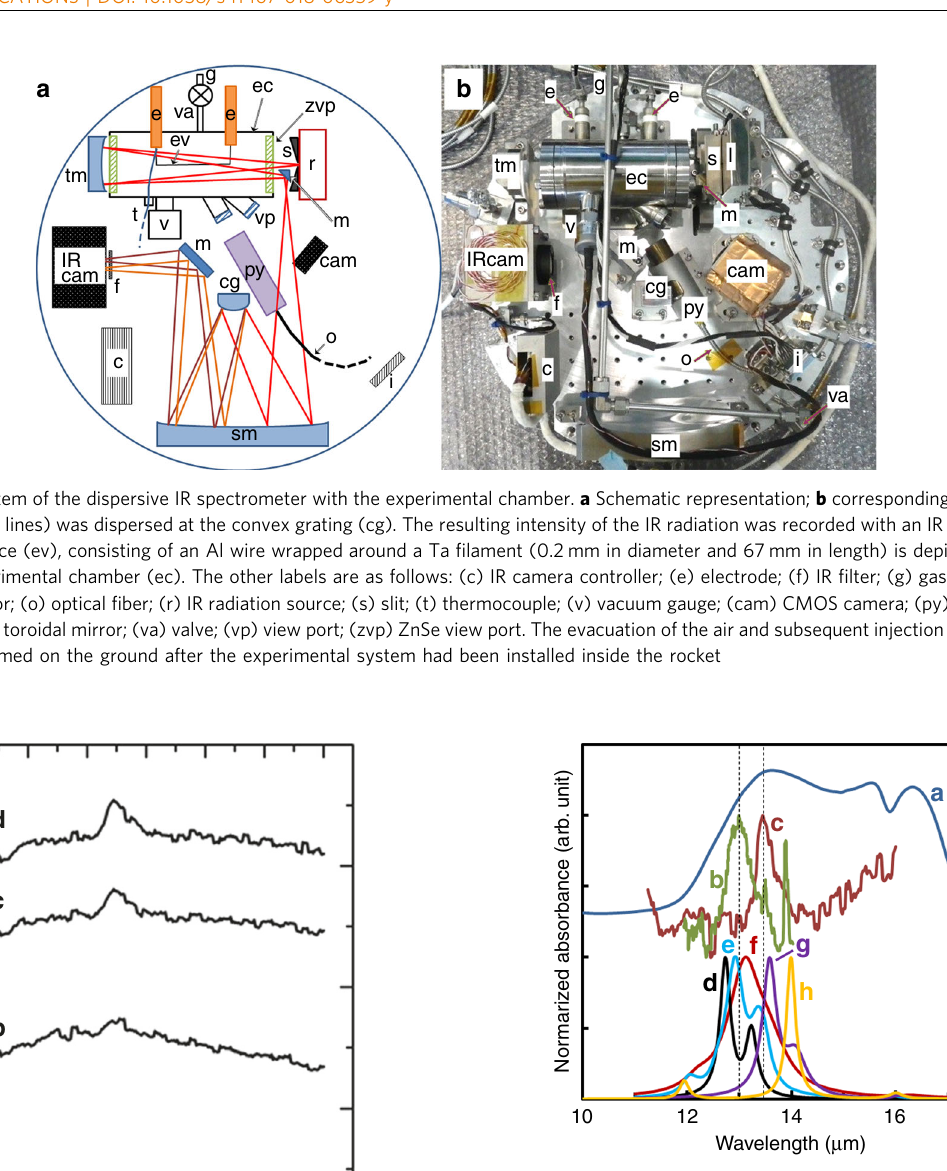
Fig. 3 Comparison of IR spectra. These spectra were obtained: a with laboratory measurements on α -Al 2 O 3 embedded in a KBr medium (blue) 23 ; b by observation of AGB stars (khaki) 4 ; c in this study (brown). Calculated spectra of d : spheres at 300 K (black); e faceted particle at 300 K (light blue); f spheres at 928 K (magenta); g spheres with surface contamination of Ta of 5 nm in thickness (purple); h oblate fl attened along c -axis with ratio of 0.3